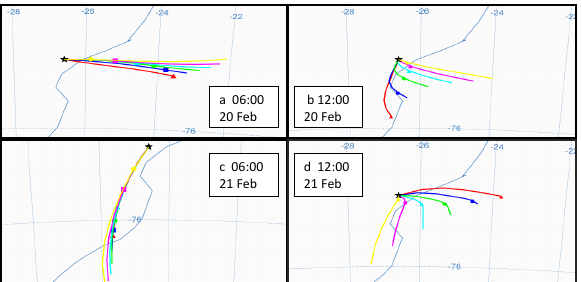
Fig. 12. 6-hour back trajectories calculated by Hysplit (NOAA 2010) for air masses reaching the air sampling site on the Brunt Ice Shelf in 2009. Trajectories arrived at the time in each chart letter (red), 1 hr previously (blue), 2 hr (green), 3 hr (turquoise), 4 hr (purple), and 5 hr (yellow).